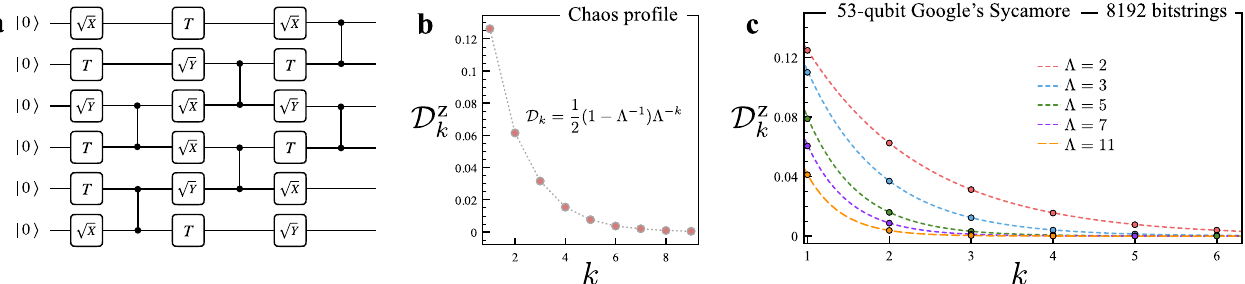
Fig. 5 Preparation of chaotic states. a Fragment of a quantum circuit generating chaotic quantum state according to the protocol proposed in ref. 30 . b Partial dissimilarities (red circles) of bit-string arrays resulting from 8192 projective measurements of a 19-layer-deep quantum chaotic circuit with 16 qubits in the σ z basis (in the random basis, the pro fi le of D k is exactly the same). Here, fi lter size Λ = 2. Dashed line shows the analytical fi t with (4). c Partial dissimilarities of bit-string arrays in the σ z basis resulting from 8192 projective measurements of the state produced by the 53-qubit Sycamore quantum processor by Google. These data were taken from ref. 6 , and different fi lter sizes Λ were used to compute D k . Dashed lines correspond to Eq. (4). Random basis measurements are not available in this